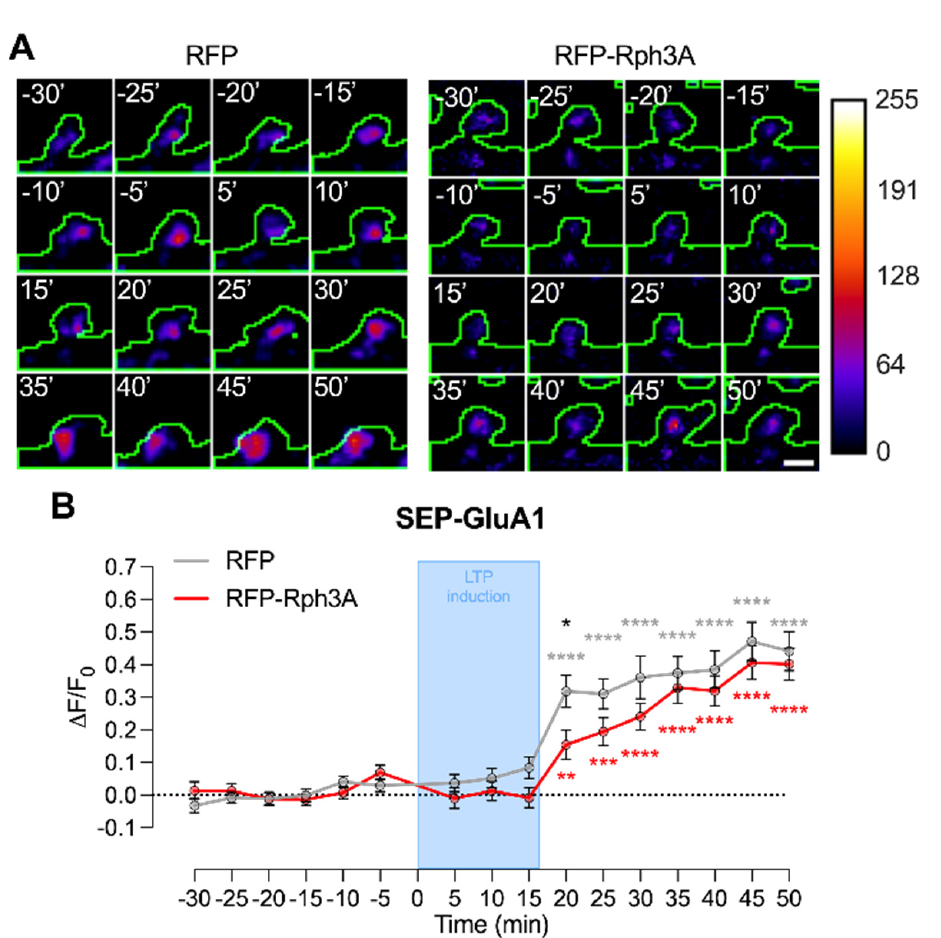
Figure 8. Rph3A overexpression and cLTP in live-imaging of SEP-GluA1 at dendritic spines. ( A ): Confocal time lapse images of SEP-GluA1 in dendritic spines of RFP ( left ) or RFP-Rph3A ( right ) transfected neurons (green outline). Scale bar: 1 µm. ( B ): Graph representing mean ± SEM Δ F/F 0 of SEP-GluA1 in RFP (grey) or RFP-Rph3A (red) transfected neurons over time before and after cLTP. Repeated measures two-way ANOVA with Dunnett’s multiple comparison test ( − 20 min vs. other time points, RFP: *grey, RFP-Rph3A: *red) or Sidak’s multiple comparison test (RFP vs. RFP-Rph3A, *black), * p < 0.05; ** p < 0.01; *** p < 0.001; **** p < 0.0001.